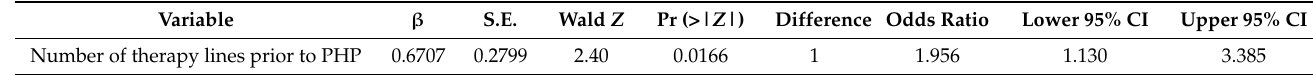
Table 5. Proportional odds model relating line of therapy to response after therapy (CR/PR versus SD versus PD). The parameter estimates β , the standard errors S.E., the statistic (Wald Z), the p -value (Pr (>|Z|)), the difference between the higher and lower value of the predictor being compared (Difference), the odds ratio (Odds ratio), and the 95% confidence interval (Lower 95% CI, Upper 95% CI). PHP: percutaneous hepatic perfusion.